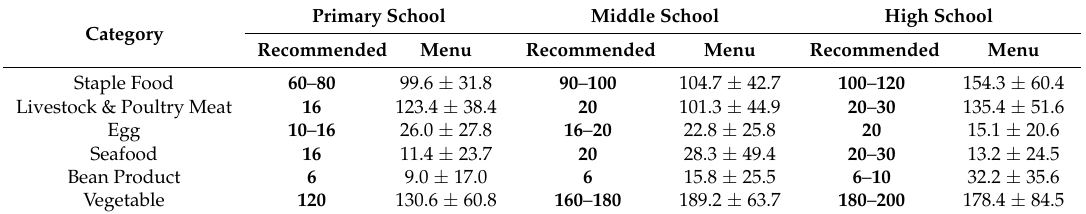
Table 1. Provision of food in the menus of twenty schools as compared to CNDG-Children 2016/g. Primary School Category